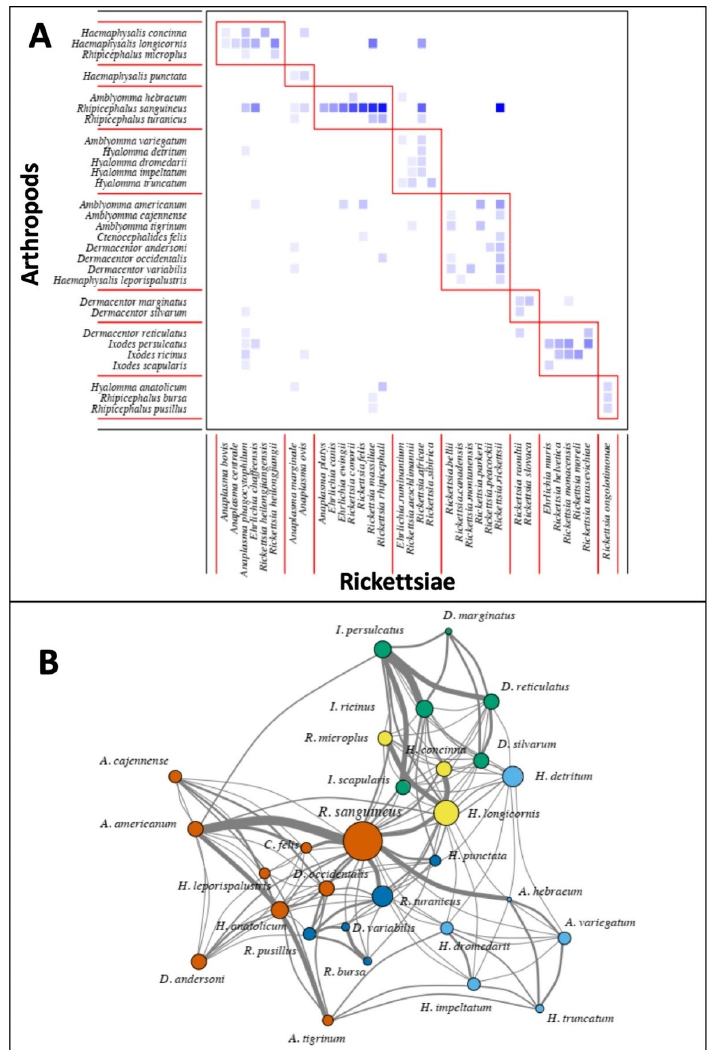
Figure 4. Composite panels of modules identified using ( A ) bipartite networks and ( B ) subgroups identified by unipartite networks subgroups (di ff erentiated by colors) of shared rickettsial species among arthropod species The links among nodes (node = species) of the unipartite network depict shared pathogens / arthropod species (vertices were placed according to the Fruchterman–Reingold algorithm) with thickness of links proportional to number of rickettsial species shared and size of vertices proportional to the degree centrality of carriers (nodes). List of arthropod species is given in Figure 2. Data were extracted from the EID2 database